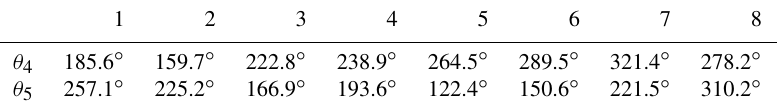
Table 3. Singularity